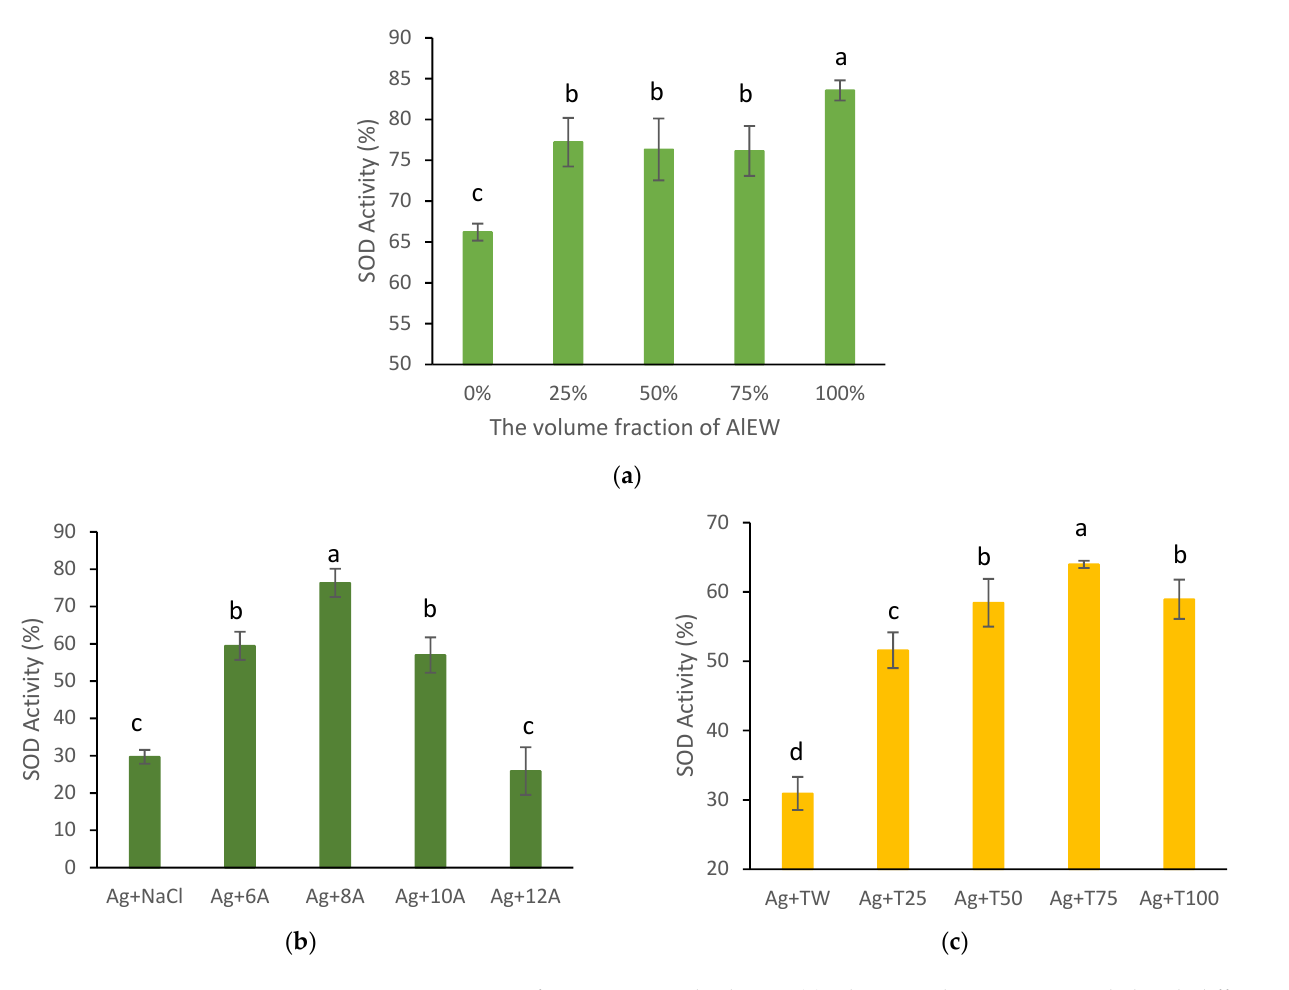
Figure 2. SOD activity of SIW compound solution; ( a ), The 200 ppb SIW compounded with different volume fraction of 8A − AlEW; ( b ), The 200 ppb SIW compounded in a 1:1 ratio with AlEW generated at different electrolytic currents; ( c ), The 200 ppb SIW compounded in a 1:1 ratio with TMW generated at different tourmaline stone treatment temperature. TW, tap water; Ag+6 A/T25, silver-ionized water is compounded with AlEW generated at an electrolytic current of 6 A or TMW generated at a tourmaline stone treatment temperature of 25 °C. Different letters indicate a significant difference ( p < 0.05). Each value is expressed as the mean value ± standard deviation of three replicates. All sample solutions in this study contained 2 mmol/L AsA.